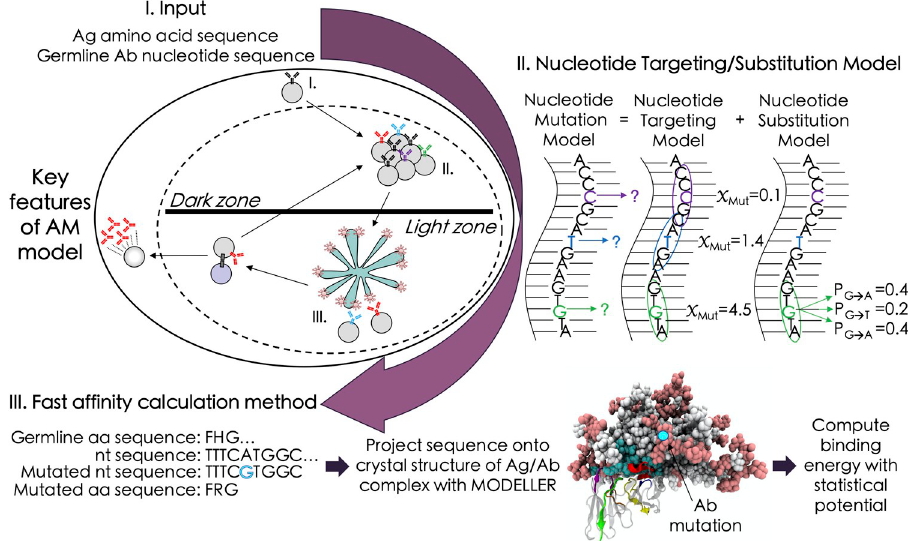
Fig 1. Simulation framework for the AM model, highlighting new features. Amino acid (aa) and nucleotide (nt) sequences of the Ag and germline BCR, respectively, are input into the model in step I. During B cell proliferation and mutation (step II), a mutation model [19] is used to determine where and which mutations will occur in the BCR sequences; nts that have a higher mutability score ( χ Mut )–which accounts for the effects of surrounding nts–have a greater chance of being selected for mutation. This is followed in step III by BCR/Ag binding free energy calculations, which utilize the program Modeller [25] and published statistical potentials [26]. Final steps in the model include a second selection step, recycling, and differentiation (details in text). BCR breadth is computed as the fraction of Ags in a panel for which the BCR binds above a chosen threshold (see Methods).